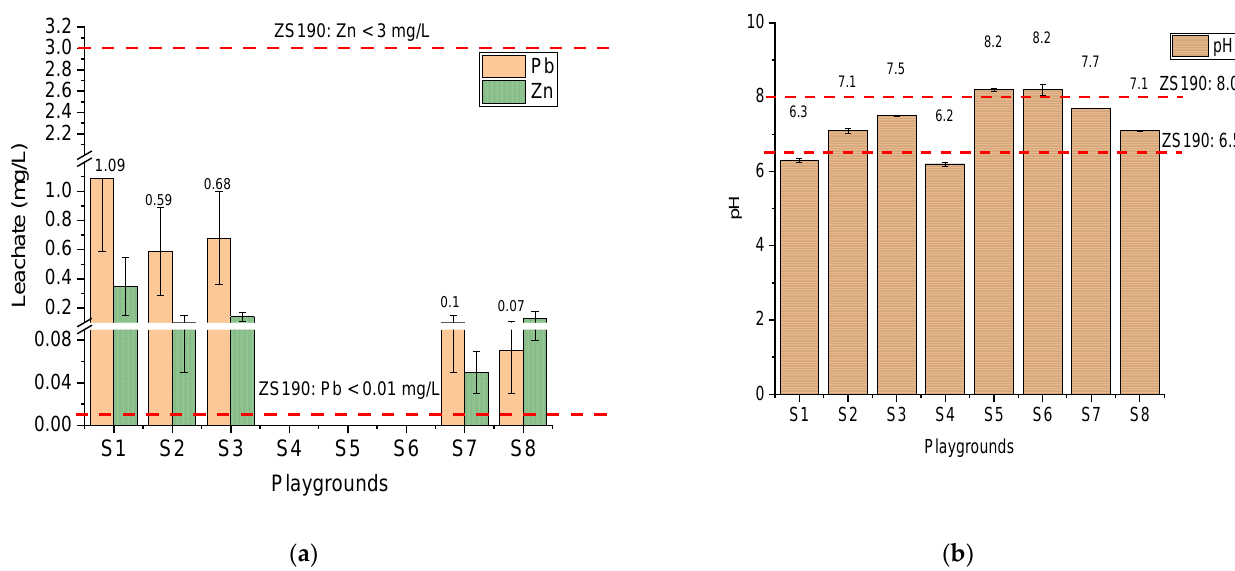
Figure 3. Leachate characteristics for the SPs: ( a ) water-soluble Pb and Zn ( b ) pH. The dotted line represents permissible limits for drinking water standards in Zambia (ZS190.2010). Table 4. Principal Component Analysis (PCA) for Water-Soluble Pb and Zn, including Total Variance, Eigenvalue, and Cumulative